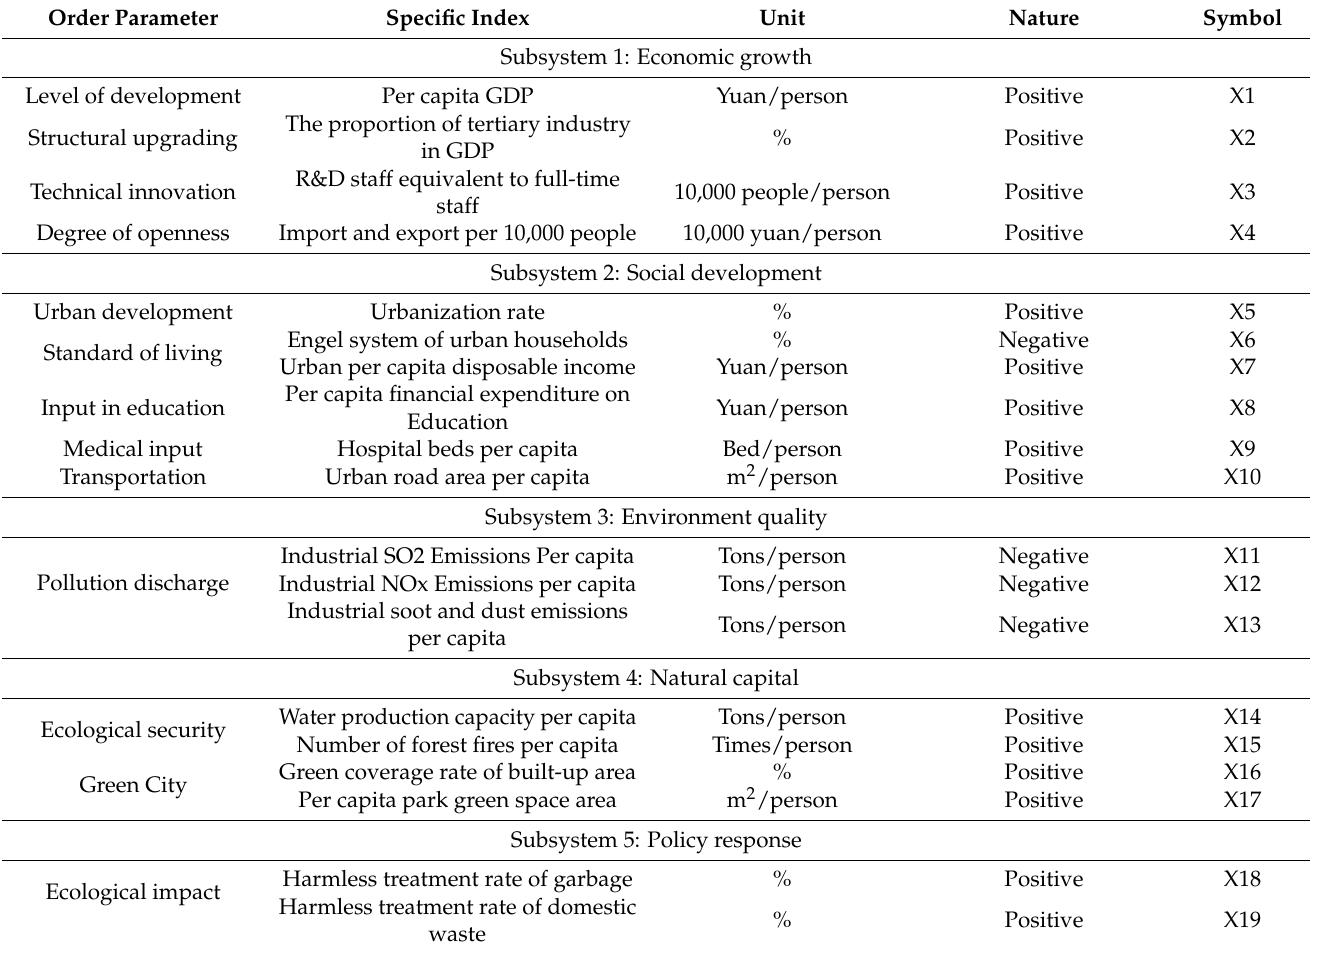
Table 1. Evaluation index system of